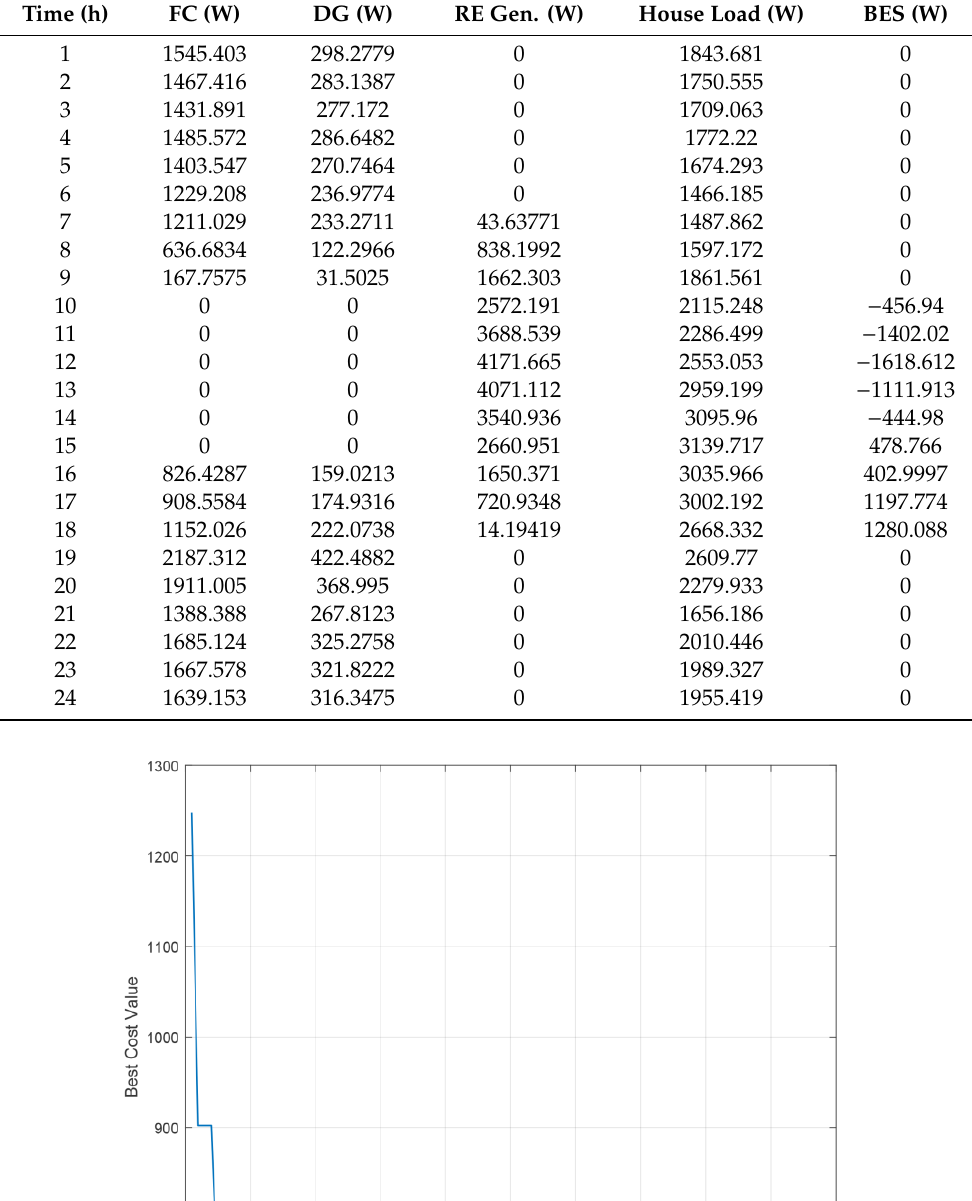
Figure 19. Operation of the fuel cell and a diesel generator in the microgrid on July 28th, 2016 controlled by optimized FLEMS considering economic dispatch using PSO. To investigate the effectiveness of the proposed method using economic dispatch within the microgrid FLEMS, three different scenarios are simulated: 